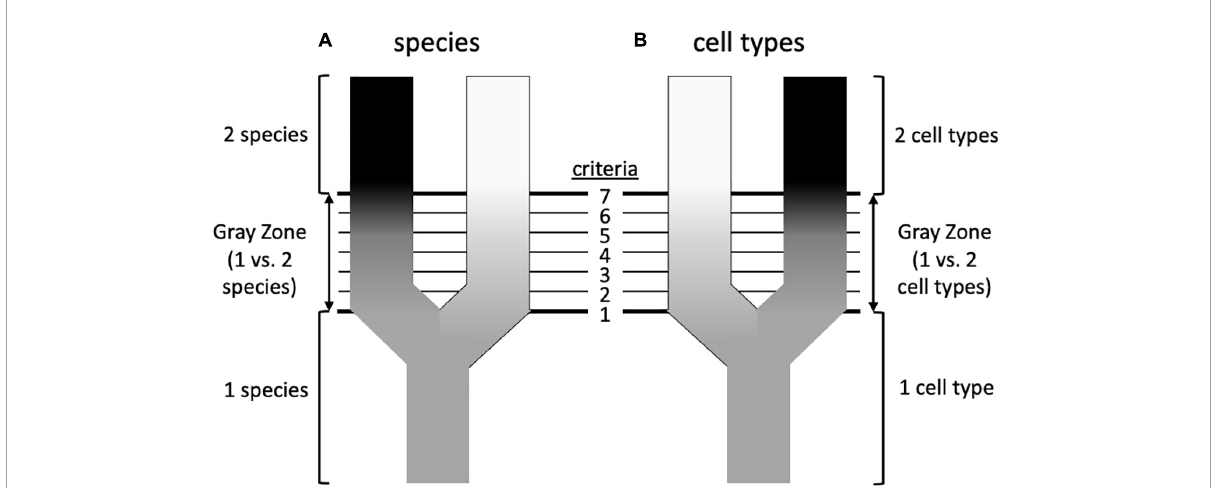
FIGURE2 Possible similarities between speciation and the formation of cell types (based on de Queiroz, 2007). (A) Speciation involves the splitting of an ancestral species into two sister species. Initially, all systematists, regardless of their species concept, will agree that there is only a single species, and at some later point will again agree that there are unambiguously two species. However, in between there is a “gray zone” where there is disagreement. This is because there are various properties (an arbitrary number of seven is shown here) that diverging taxa acquire over time, such as reproductive isolation, morphological differentiation, occupation of different ecological niches, reciprocal monophyly, etc. These various properties are criteria by which systematists diagnose species, but each is prioritized differently in different species concepts. This leads to disagreement about species status in the gray zone: a systematist prioritizing criterion 1 (e.g., phenotypic differentiation) will recognize two species at an earlier stage of differentiation than a systematist prioritizing criterion 7 (e.g., reproductive isolation), which in the sequence shown here is not reached until later. This would be less of a problem if the criteria considered diagnostic always evolved in the same sequence, but this is not the case—in this example, reproductive isolation may precede morphological differentiation in other taxa. (B) Could a similar diagram be drawn for cell types? In this case the criteria could be such features as cell morphology, cell physiology, location in a particular organ or tissue, transcriptome, preoteome, chromatin structure, and others. To the extent that there is discordance in these features, could this underlie disagreements about whether one vs. two cell types should be recognized, or perhaps two cell types vs. one cell type with two states? The criteria that are used to recognize species are not completely independent, despite their ability to evolve in different orders (e.g., reproductive isolation can lead to morphological divergence; morphological divergence can lead to reproductive isolation), so cellular criteria need not be totally disconnected from one another, but the order in which differentiation occurs may differ. For example, there is debate about whether chromatin structure drives transcription or vice versa (Krijger and de Laat,